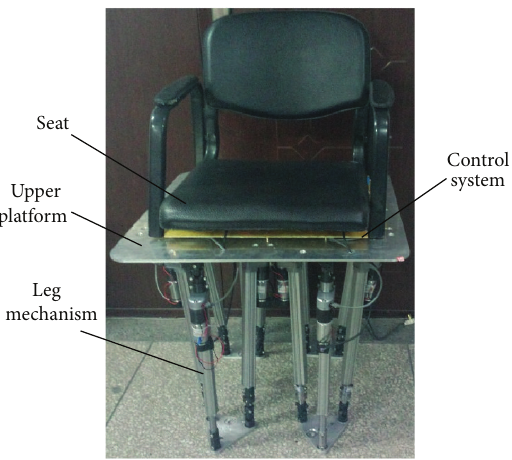
Figure 1: Human-carrying walking chair